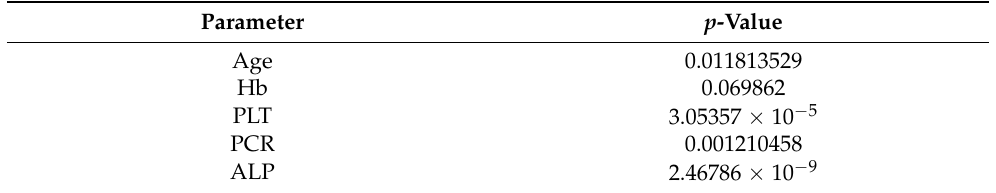
Table 3. p -value for matching parameter